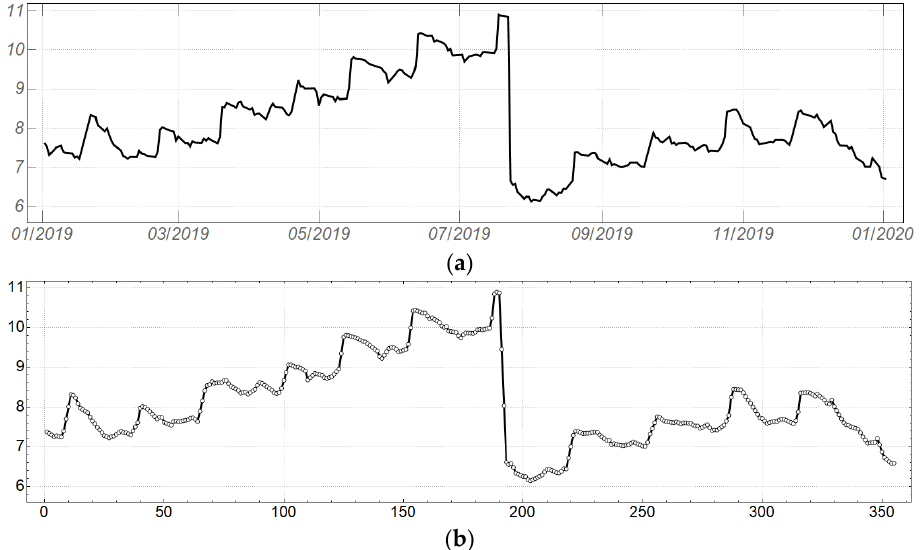
Figure 2. ( a ) Dynamics of daily cash balances in the 2019 federal budget TSA, concerning working days and original data alignment, in trillion rubles. Source: authors’ calculations. ( b ) Dynamics of daily cash balances in the 2019 federal budget TSA, concerning the ordinal number of the time step, in trillion rubles. Source: authors’